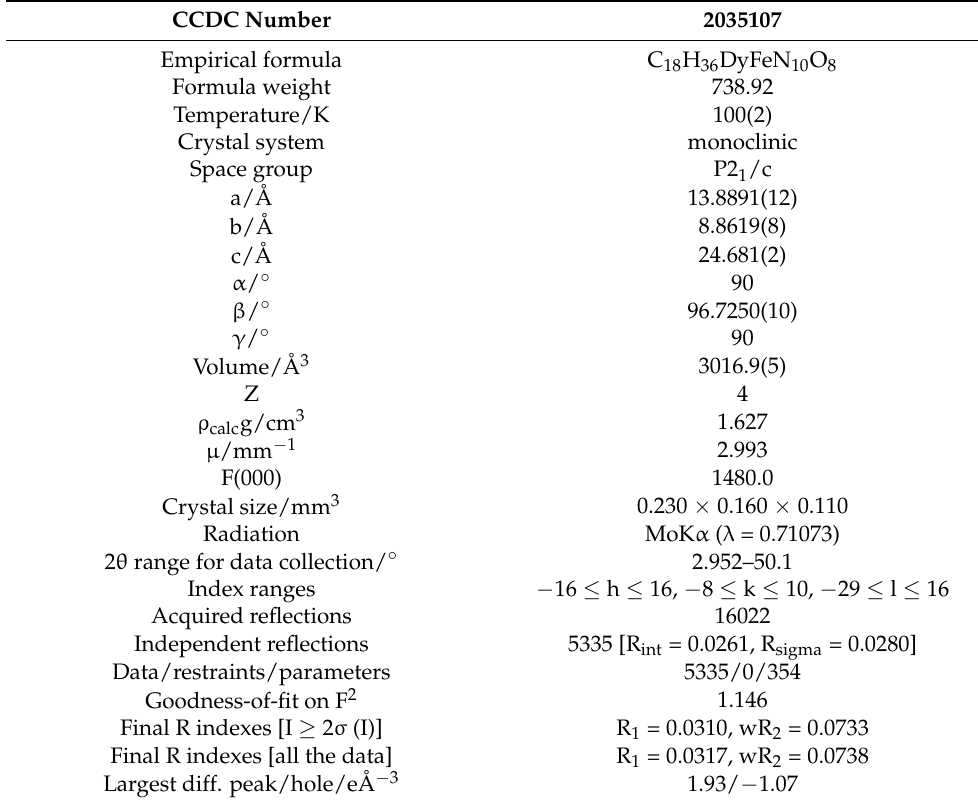
Figure 1. ( a ) Molecular complex with a C 18 H 36 DyFeN 10 O 8 composition. ( b ) Standard representation of the underlying net (right). ZA = H 2 O, ZB = DMF, ZC = CN, ZD = Fe, ZE = Dy. The hydrogen atoms that did not participate in the H-bonding were omitted for clarity. The underlying net in the stan- dard representation of the H-bonded molecular metal–organic frameworks (MOFs) is shown in the ( c ) (0,1,0) (left) and ( d ) (1,0,0) projections. The red spheres represent the molecular complexes; the yellow spheres describe the H 2 O molecules. The unit cell of the structure is represented by a blue line. Table 1. Crystal data and structure refinement for 1